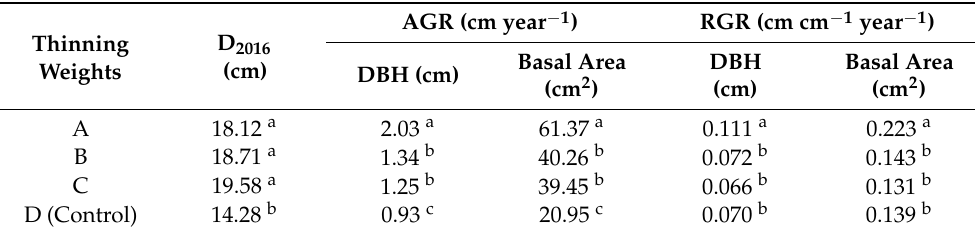
Table 3. Average values of initial DBH (D2016) and of absolute (AGR) and relative growth rate (RGR) in DBH and basal area of laurel tree in plots subjected to different thinning levels, Sumaco Protected